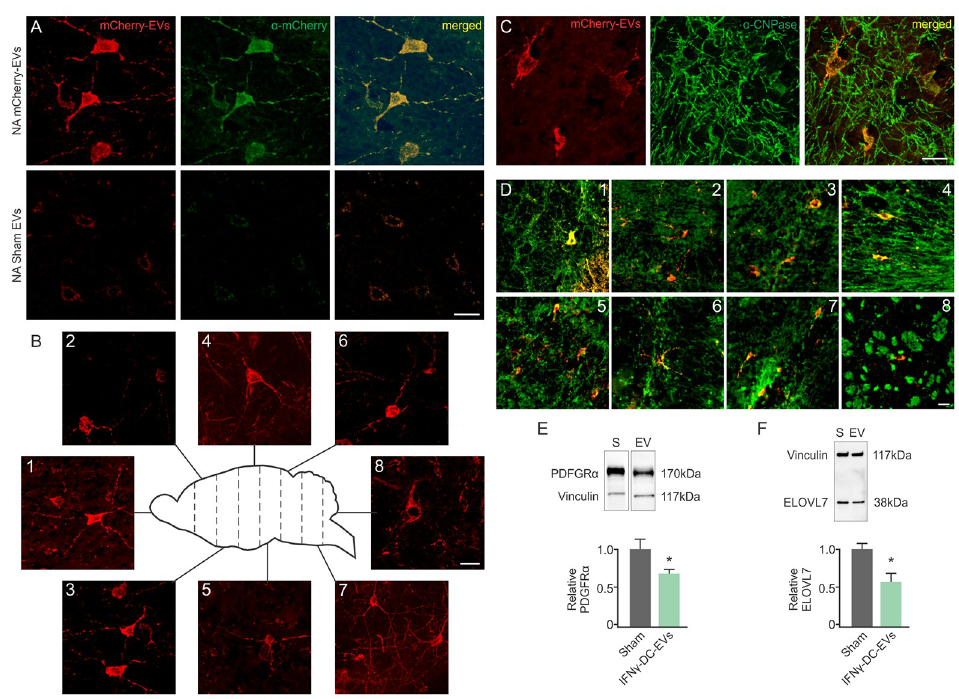
Fig 2. Nasally administered IFN γ -DC-EVs deliver their contents to brain cells. IFN γ -DC-EVs were transfected with reporter mCherry mRNA. (A) Nasal delivery of transfected EVs (NA mCherry-EV) confirmed EV delivery of functional mCherry mRNA to brain cells. Representative images show mCherry fluorescence (red), anti-mCherry immunostaining (green) and merged image (yellow) to confirm mCherry expression in cells. Animals that were nasally administered untransfected EVs (Sham) showed no mCherry expression/staining. Scale bar = 25 μ m. (B) Representative merged images (B1-8) show widespread cellular distribution in the CNS two days after nasal administration of mCherry mRNA transfected IFN γ -DC-EVs. Images were taken from brain sections represented in the schematic. A subset of mCherry- positive cells colocalize with CNPase, indicating that they are oligodendrocytes. (C) Representative high power images of mCherry expression (red) in cells that co-stained (yellow) for CNPase (green). Scale bar = 25 μ m. (D) Similarly, stained representative merged images (D1-8) show oligodendrocyte co-staining throughout the CNS, with numbers corresponding to brain areas in schematic (B). Scale bar = 20 μ m. ( n = 5-7/group; A-D). To confirm that IFN γ -DC-EVs delivered cargo to oligodendrocytes, protein expression levels of known miR-219 mRNA targets expressed in oligodendrocyte lineage cells were quantified via immunoblot. Three days after nasal delivery of IFN γ -DC-EVs or Unstim-DC-EVs [Sham(S)], levels of (E) PDGFR α , and (F) ELOVL7 were significantly ( � p = 0.040 and 0.038 respectively) reduced in the brains of animals that received IFN γ -DC-EVs. ( n =